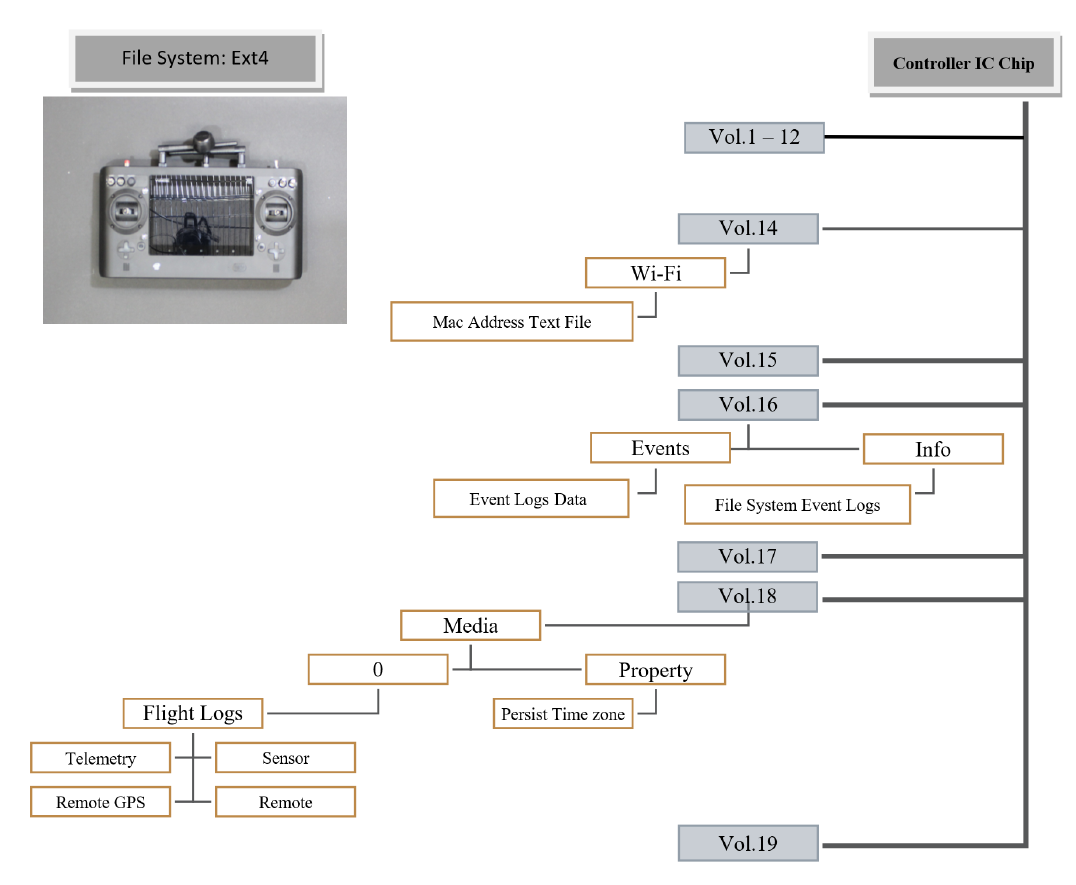
Figure 13. Structure of forensics evidence on Ground Station